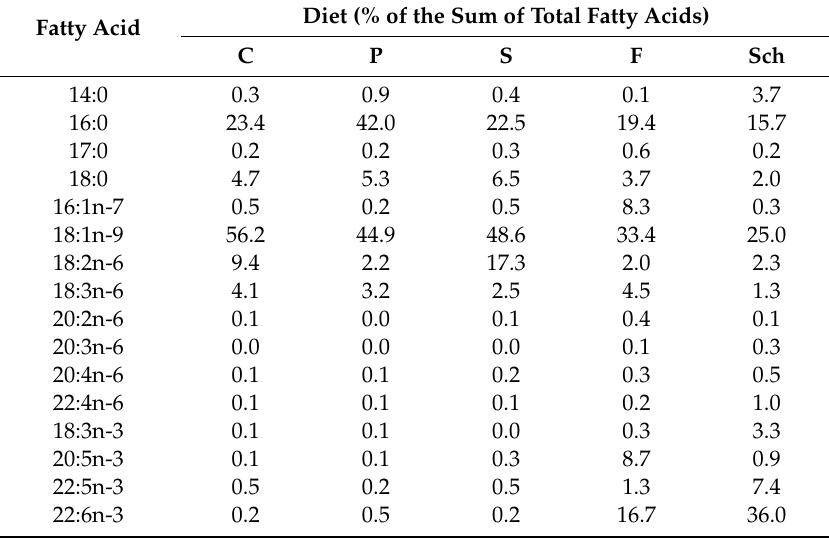
Diet (% of the Sum of Total Fatty